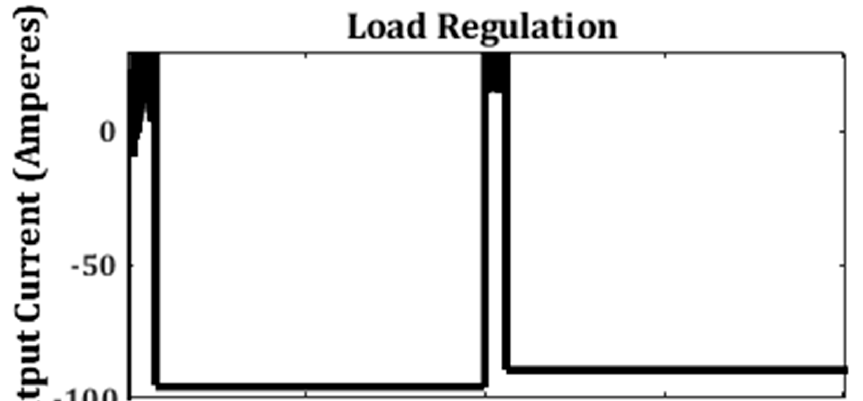
Figure 50. State of charge in %.